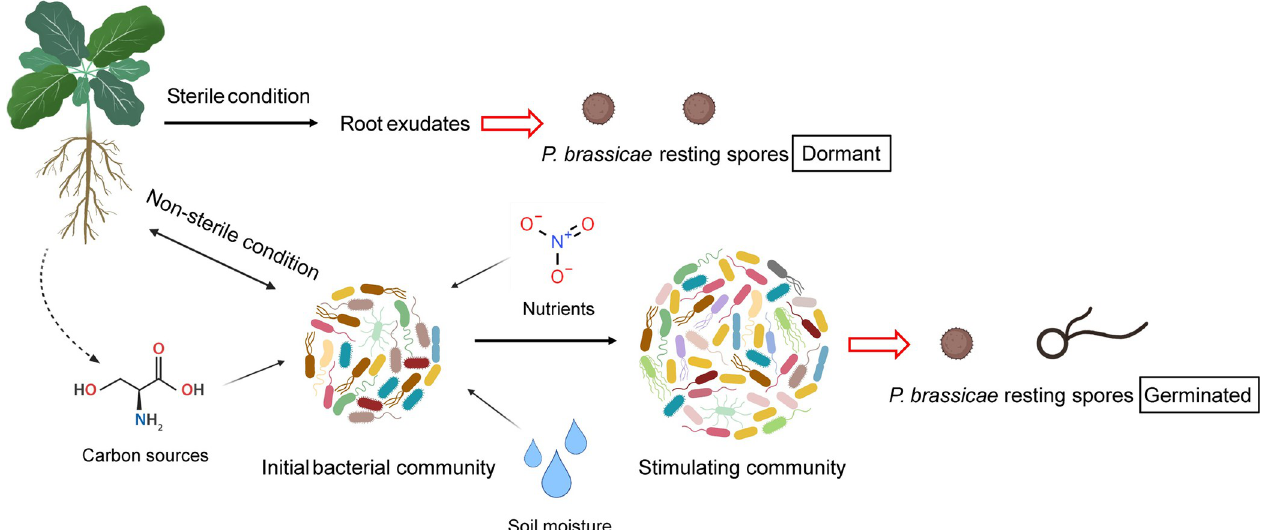
Fig 9. A multifactorial pathobiome model of factors affecting the germination of Plasmodiophora brassicae resting spores. Root exudates collected under sterile conditions cannot stimulate the germination of resting spores, while they may serve as a carbon source to modulate the microbial community under non-sterile conditions. The initial microbial community is reshaped by environmental factors (e.g. carbon sources, nutrients and soil moisture) to a community stimulating the germination of P . brassicae resting spores.